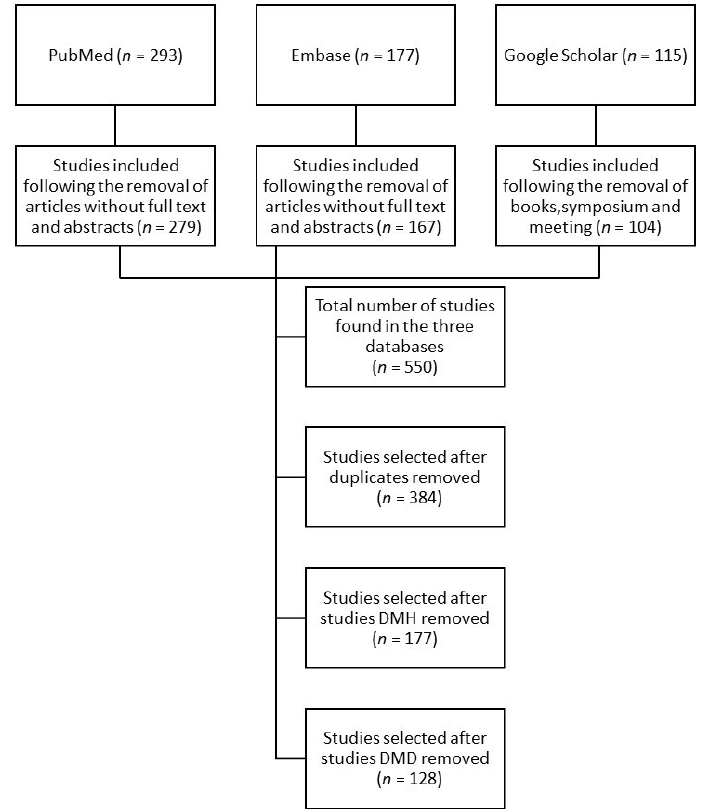
Figure 1. Flow chart of the literature selection process for the present article.